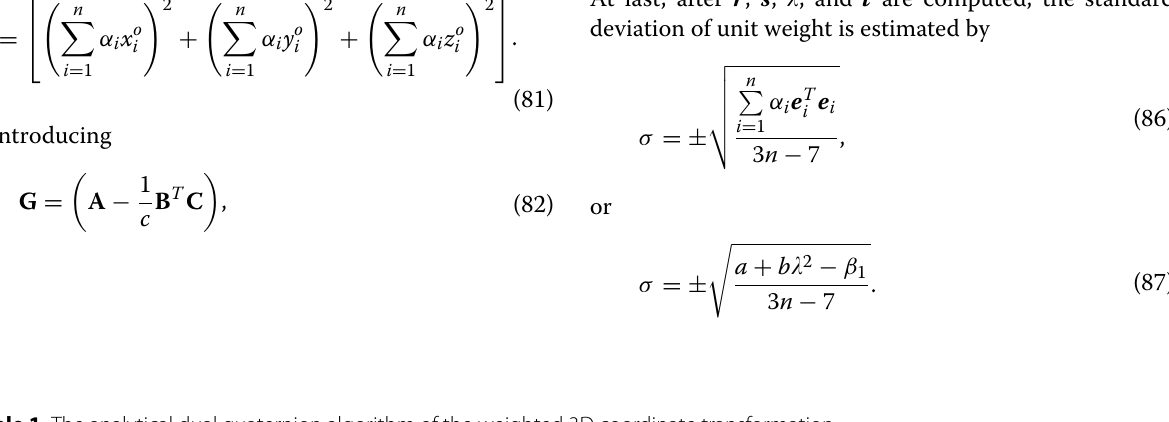
Table 1 The analytical dual quaternion algorithm of the weighted 3D coordinate